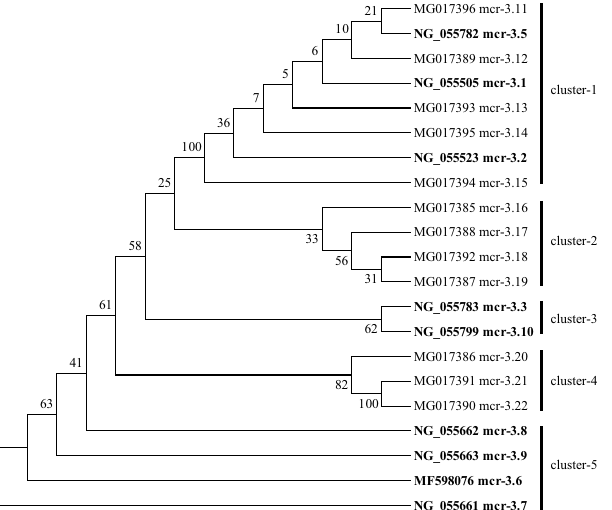
Figure 5. Evolutionary relationships of mcr-3 sequences obtained in this study. The evolutionary history of mcr-3 nucleotides (1,064-bp) identified in this study and NCBI (in bold font) was inferred using the Neighbor- Joining method. The optimal tree with the sum of branch length (0.0372) is shown. The percentage of replicate trees in which the associated taxa clustered together in the bootstrap test (500 replicates) are shown next to the branches. The evolutionary distances were computed using the Kimura 2-parameter method and are in the units of the number of base substitutions per site. After eliminating the positions containing gaps and missing data, there were a total of 1,063 positions in the final dataset. Evolutionary analyses were conducted in